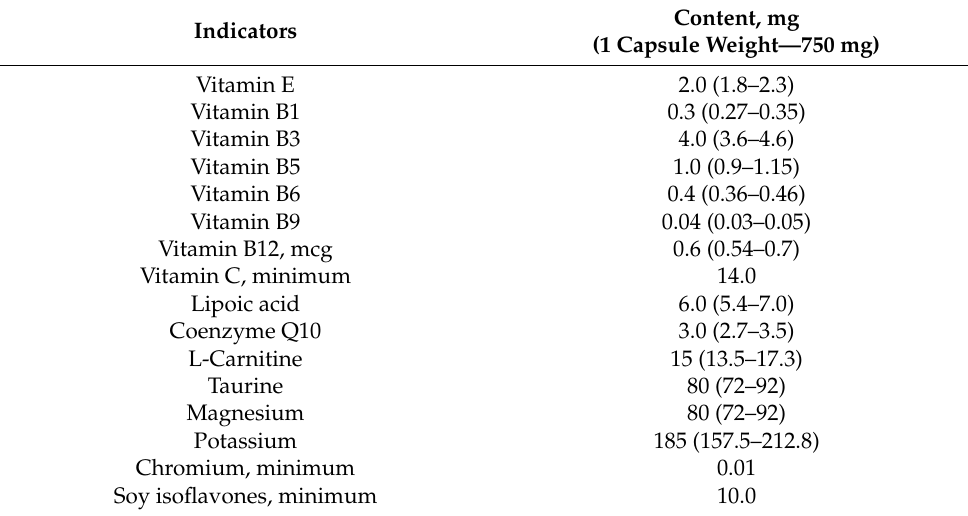
Table 2. The product nutritional value